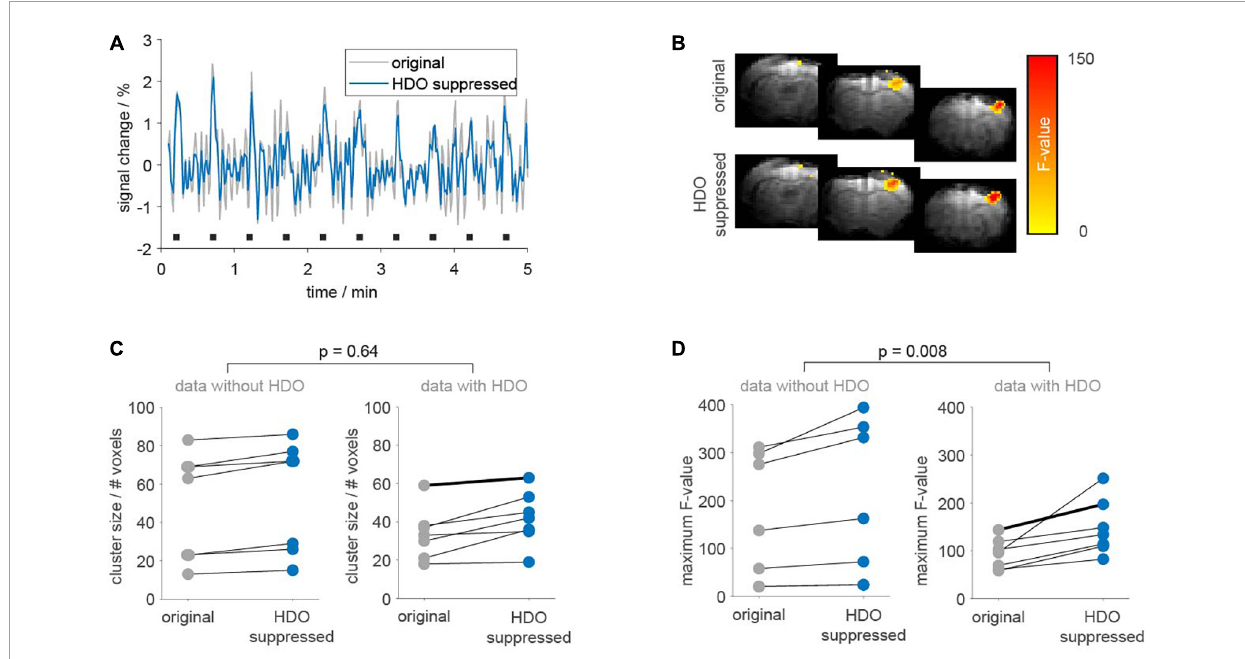
FIGURE8 Application of the suppression algorithm improves GLM-based analysis of fMRI data. GLM-based analysis was performed on 14 fMRI datasets before (gray) and after HDO suppression (blue). (A) Periods (5 min) of BOLD time courses and (B) activation maps of one exemplary oscillating dataset. Duration of electrical paw stimulation were highlighted by black bars. (C) Cluster sizes and (D) maximum F -values resulting from GLM-based analysis of BOLD activation are shown separately for data with and without HDO ( n = 7, each). Data points for identical measurements are connected by lines. Bold lines indicate the dataset shown in panels (A,B) . U -tests were used to test for significant differences between relative cluster sizes and relative F -values of data with and without HDO.